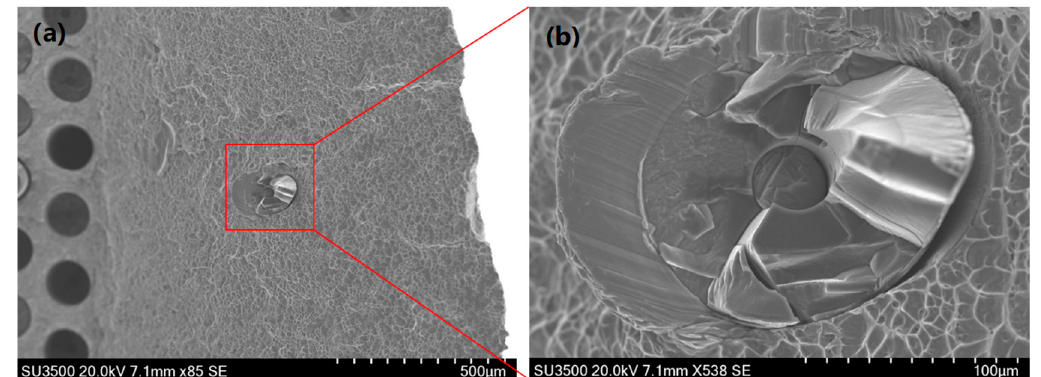
Figure 8. Ductile failure in out-of-phase test at 1200 MPa. ( a ) SEM image of fibre fragment within the cladding region; ( b ) higher magnification SEM image showing ductile failure and fibre contact marks. Region II is visible for both IP and OP tests. For these conditions, matrix dominated failures occur widely. Typically, the OP failures initiate from subsurface quasi cleavage facets of the type increase in stress comes a reduction in crack area upon failure. It can be seen in Figure 9 that the area encompassed by the crack reduces with higher stress and with OP conditions. This is consistent with Griffith’s theory that strength is inversely proportional to the square root of the crack length [16]. In